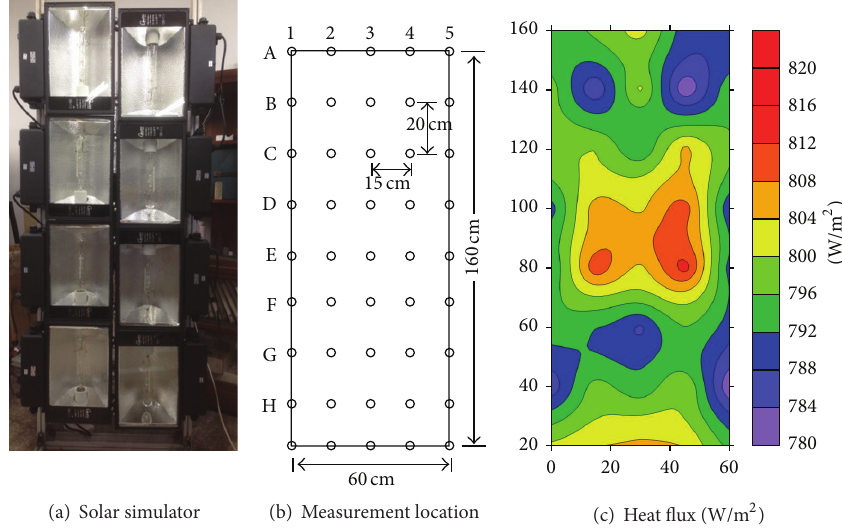
Figure 2: Distribution of heat flux on glazing for solar simulator.